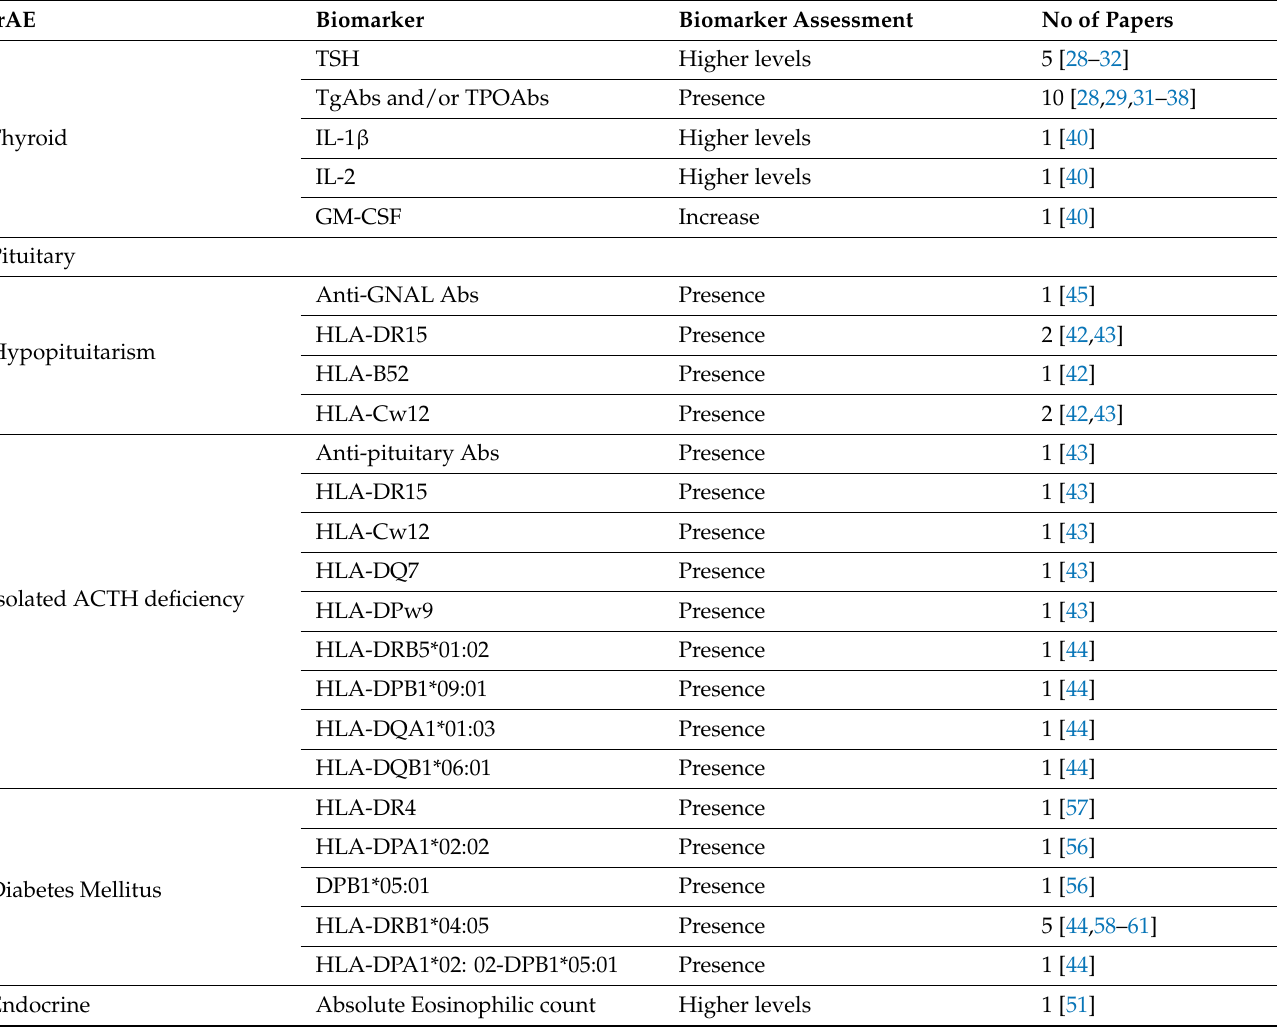
Table 1. Pre-treatment biomarkers for irAEs.